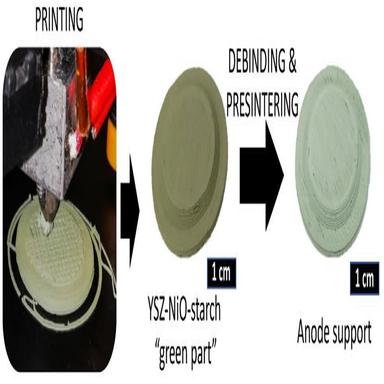
Ni-YSZ anode support, electrolyte and cathode schematically represented (thicknesses included in brackets) in the manufacture FFF-cell ready for the electrochemical characterization.